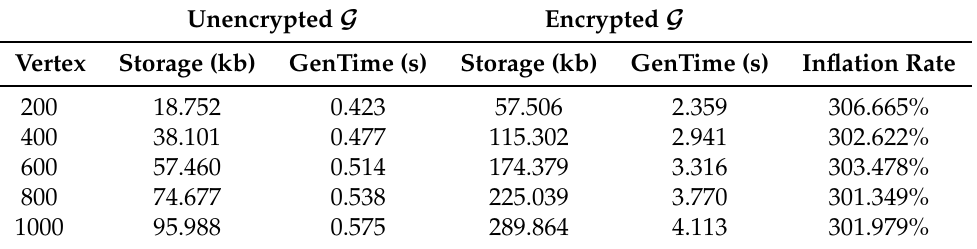
Table 3. Storage cost.